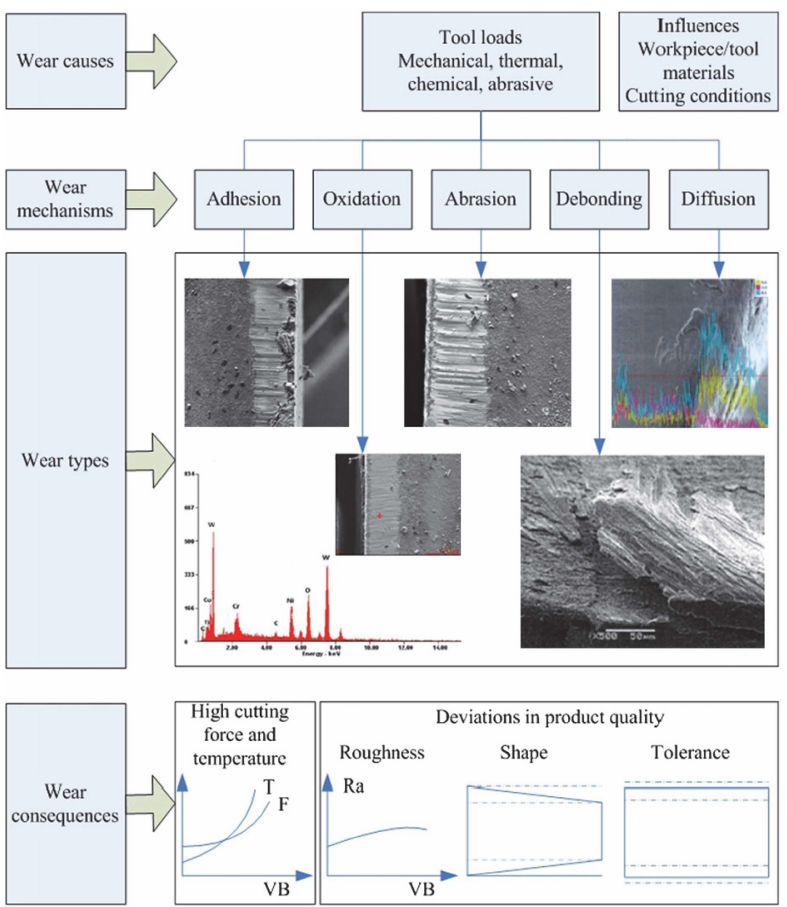
Figure 1. The wear causes, wear mechanisms, wear types, and wear consequences in the cutting of nickel-based superalloys